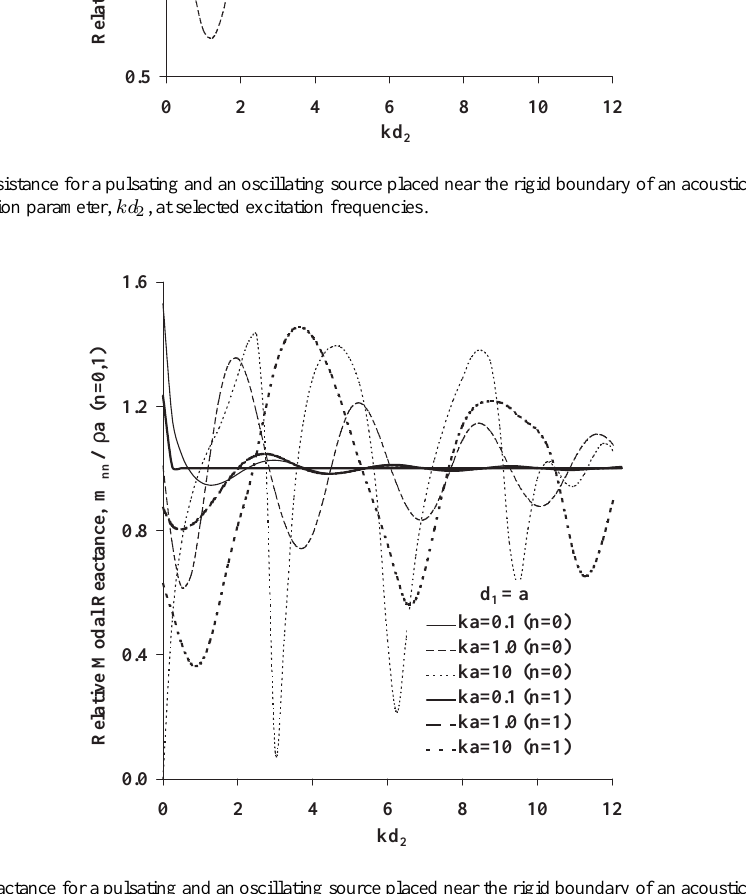
Fig. 7. Relative acoustic reactance for a pulsating and an oscillating source placed near the rigid boundary of an acoustic quarterspace at d 1 = a as a function of the separation parameter, kd 2 , at selected excitation